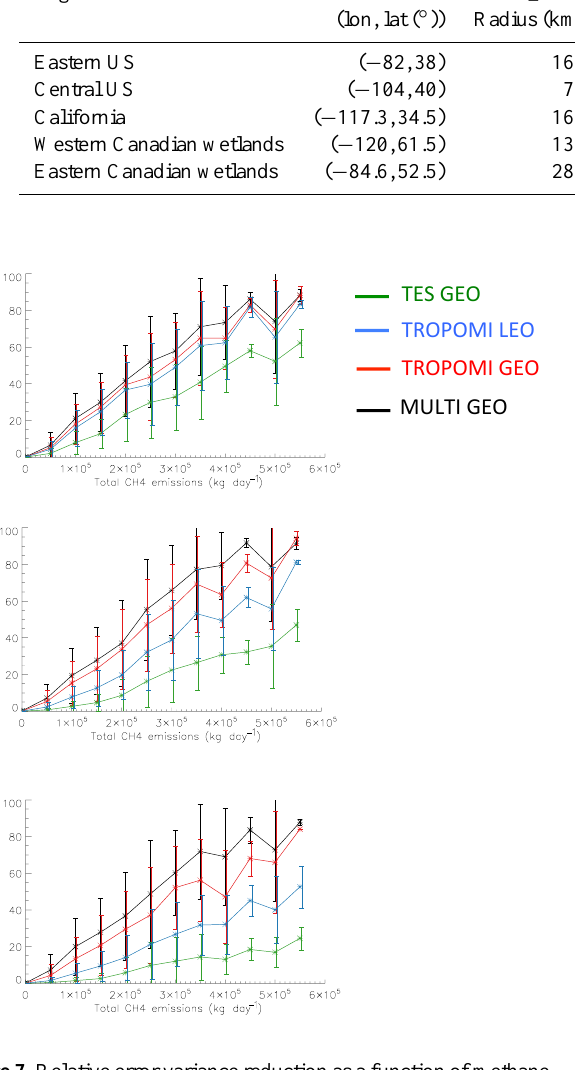
Figure 7. Relative error variance reduction as a function of methane emission magnitude for a (a) 30-day (1–30 July 2008), (b) 7-day (1–8 July 2008), and (c) 3-day (1–4 July 2008) inversion. Blue: TROPOMI low-Earth orbit observations (TROPOMI_LEO); green: GEO-CAPE observations with a TES-like instrument (TES_GEO); red: GEO-CAPE observations with a TROPOMI-like instru- ment (TROPOMI_GEO); black: GEO-CAPE observations with a multi-spectral instrument (MULTI_GEO). Results for a 3-day MULTI_GEO inversion are also shown in purple (top). The verti- cal bars indicate the standard deviation of observational constraints within each